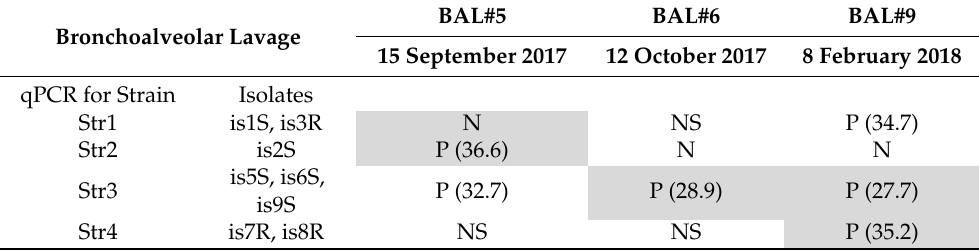
Table 3. Results of bacterial culture (grey-shading) and qPCR of three broncho-alveolar lavages for four different Achromobacter xylosoxidans strains isolated in a 12-year-old boy after double lung